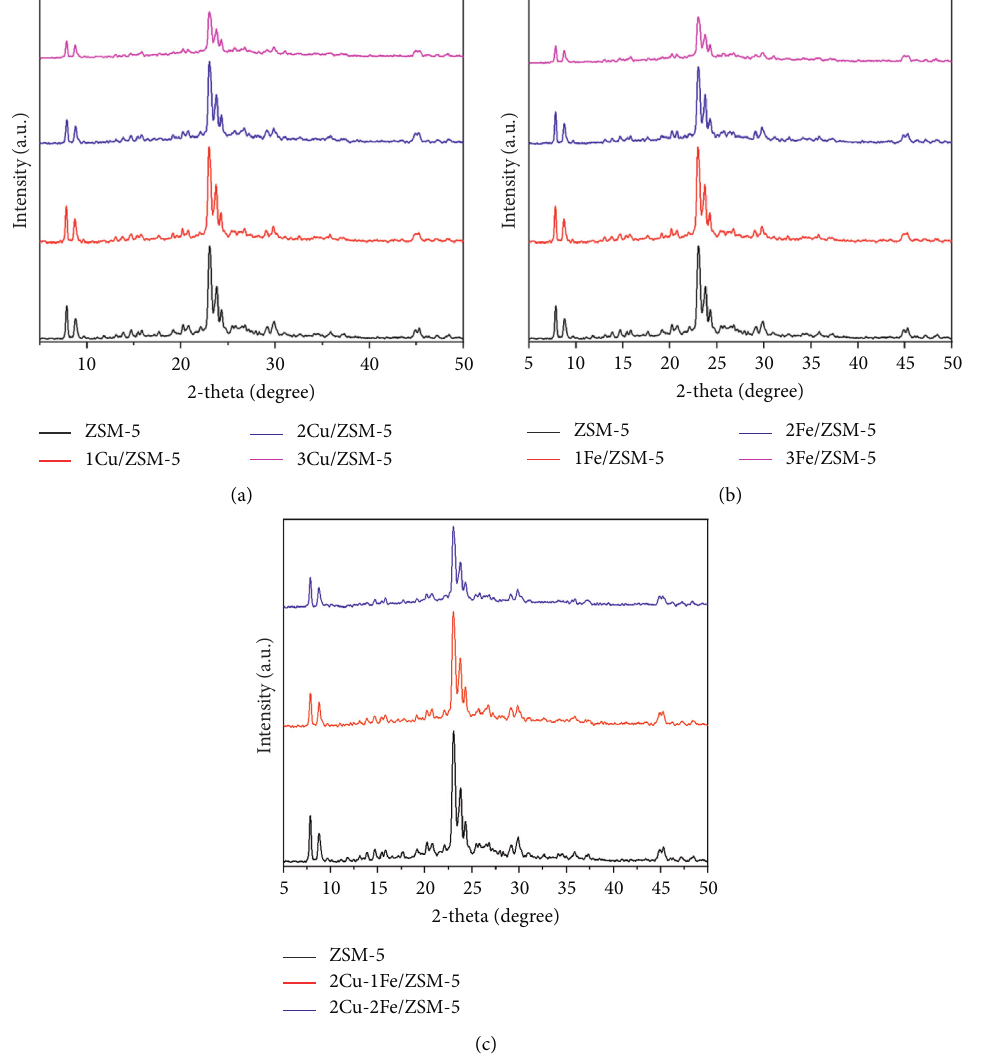
Figure 2: XRD patterns of (a) Cu/ZSM-5, (b) Fe/ZSM-5, and (c)